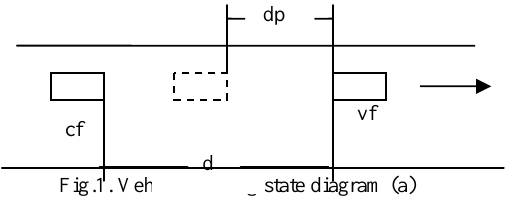
Fig.1. Vehicle driving state diagram